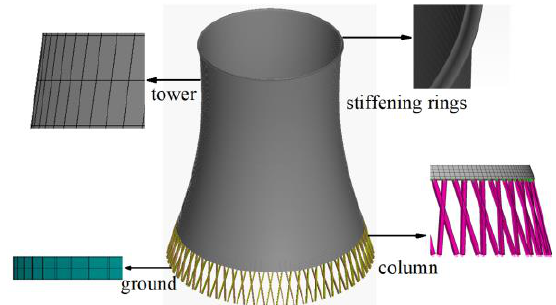
Figure 12. The finite element model of the cooling tower.